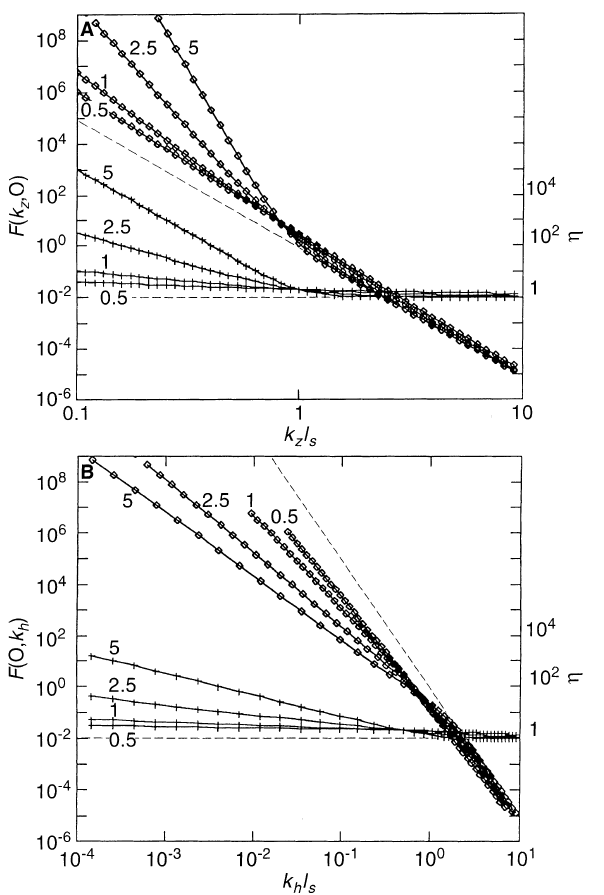
Fig. 2A,B. The 3D spectra F (cid:133) k z ; k h (cid:134) ( diamonds ) and anisotropy coe(cid:129)cients (cid:103) ( crosses ) for the family of Eq. (4) and for E (cid:133) q (cid:134) (cid:136) q (cid:255) 3 and (cid:103) (cid:133) q (cid:134) (cid:136) 1 (cid:135) (cid:133) ql s (cid:134) (cid:255) (cid:109) . A F (cid:133) k z ; 0 (cid:134) , B F (cid:133) 0 ; k h (cid:134) ; the numbers in the plots are the values of (cid:109) ; LI spectra and (cid:103) (cid:136) 1 : dashed lines